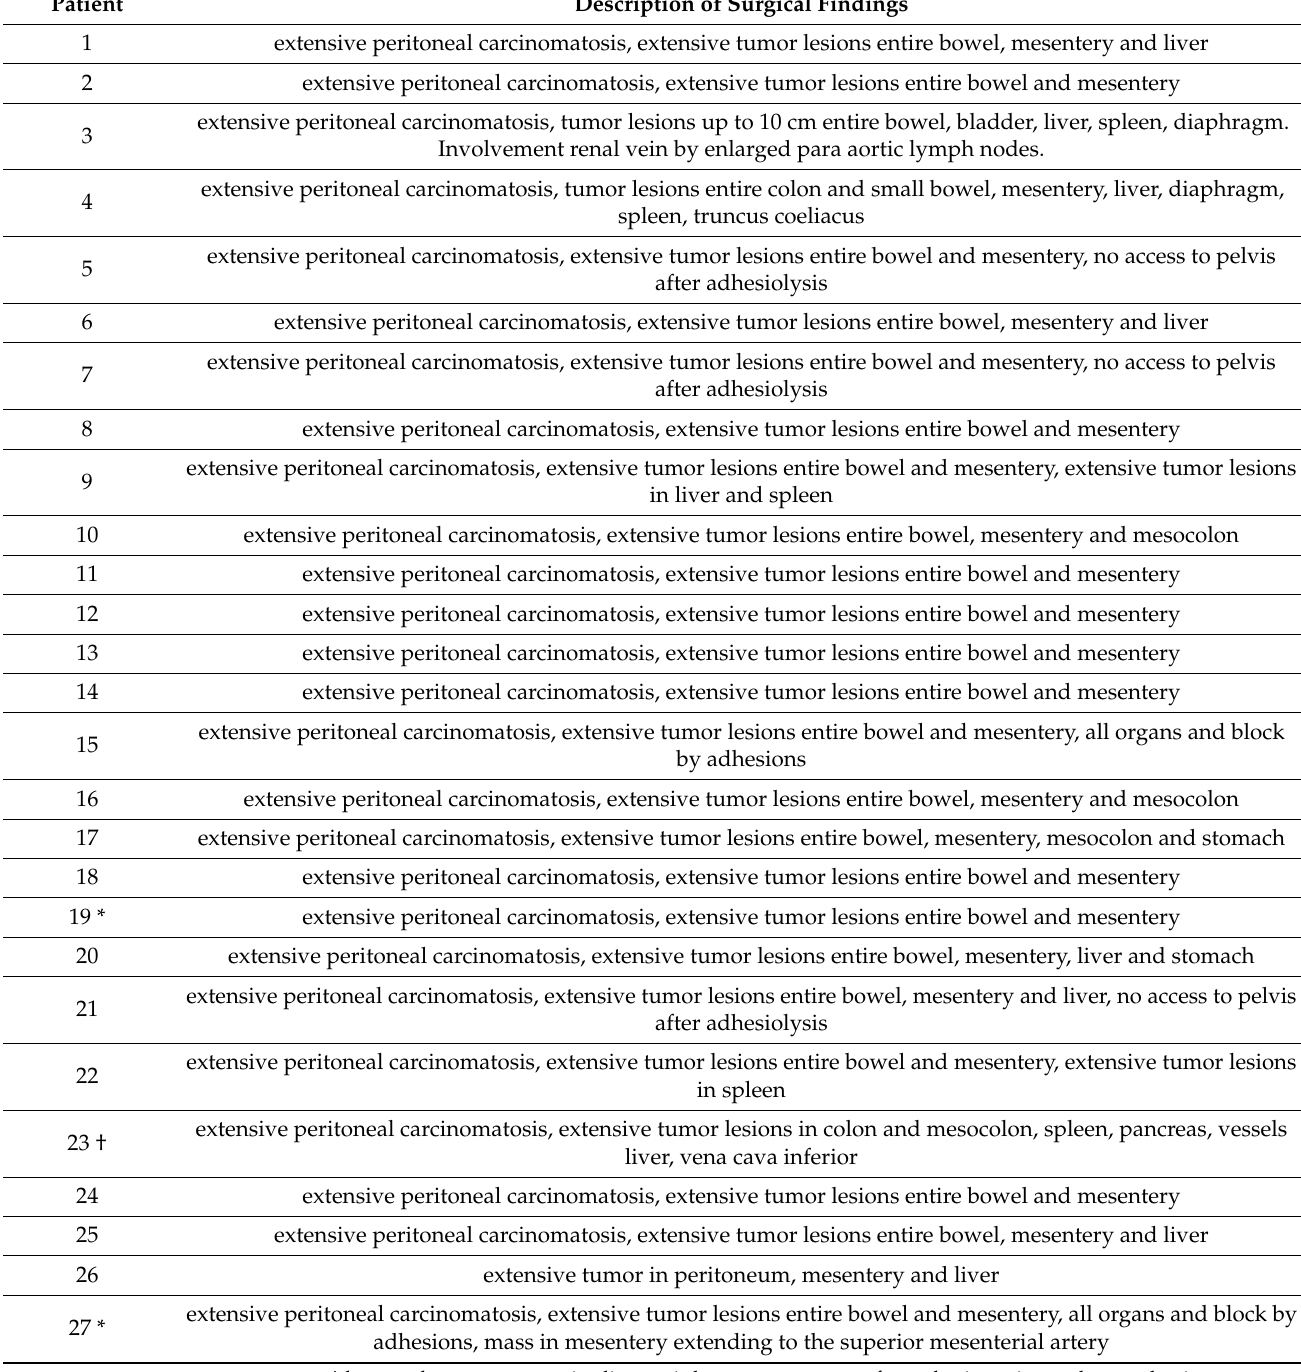
Table 2. Description of surgical